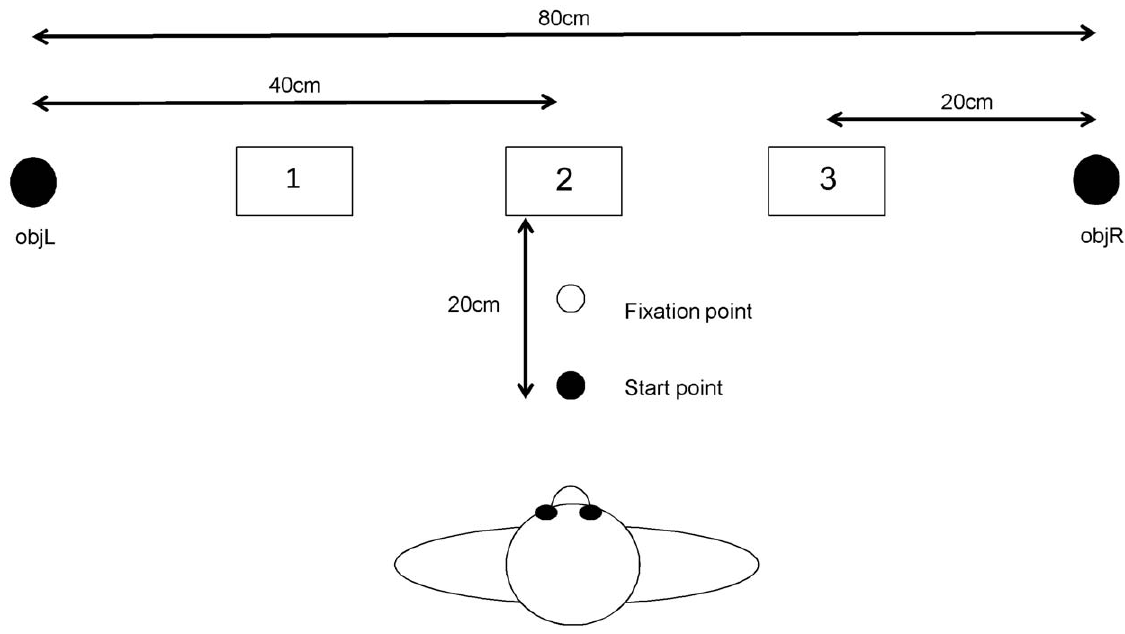
Figure 1. Diagram of experimental setup. Shows the layout of the objects and trays. Participants would start each trial with their hands resting on the start point and looking at the fixation point until one of the trays lit up. The participant would pick up objL in their left hand and objR in their right hand and place them both in the specified tray.